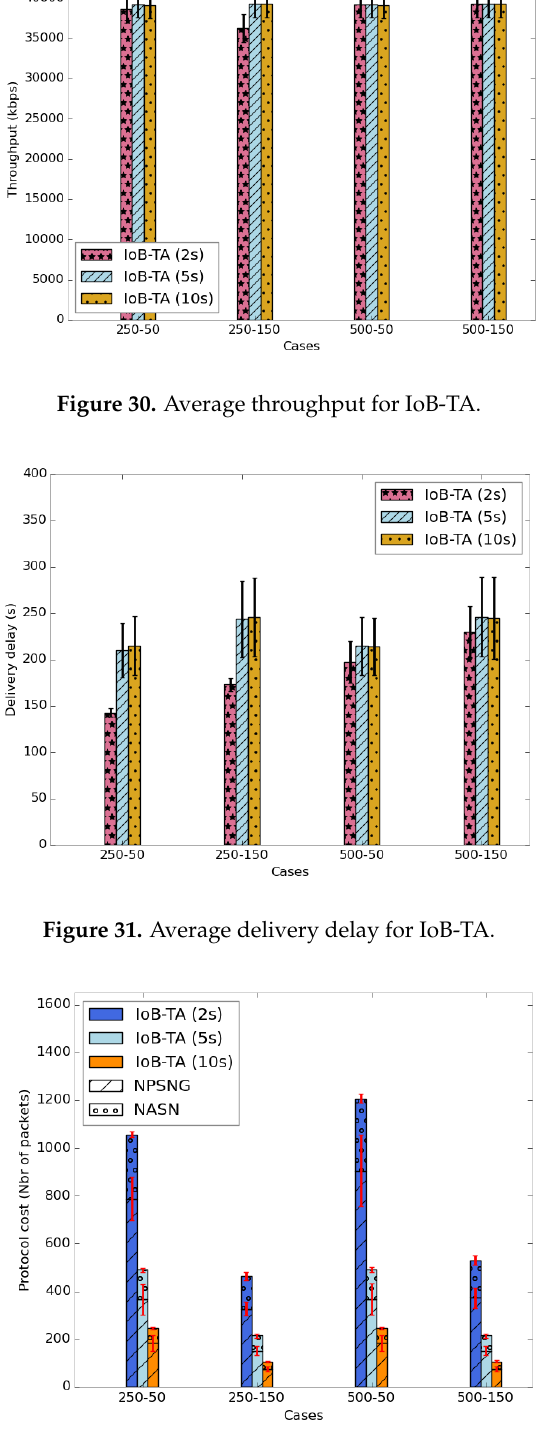
Figure 32. Average protocol cost for